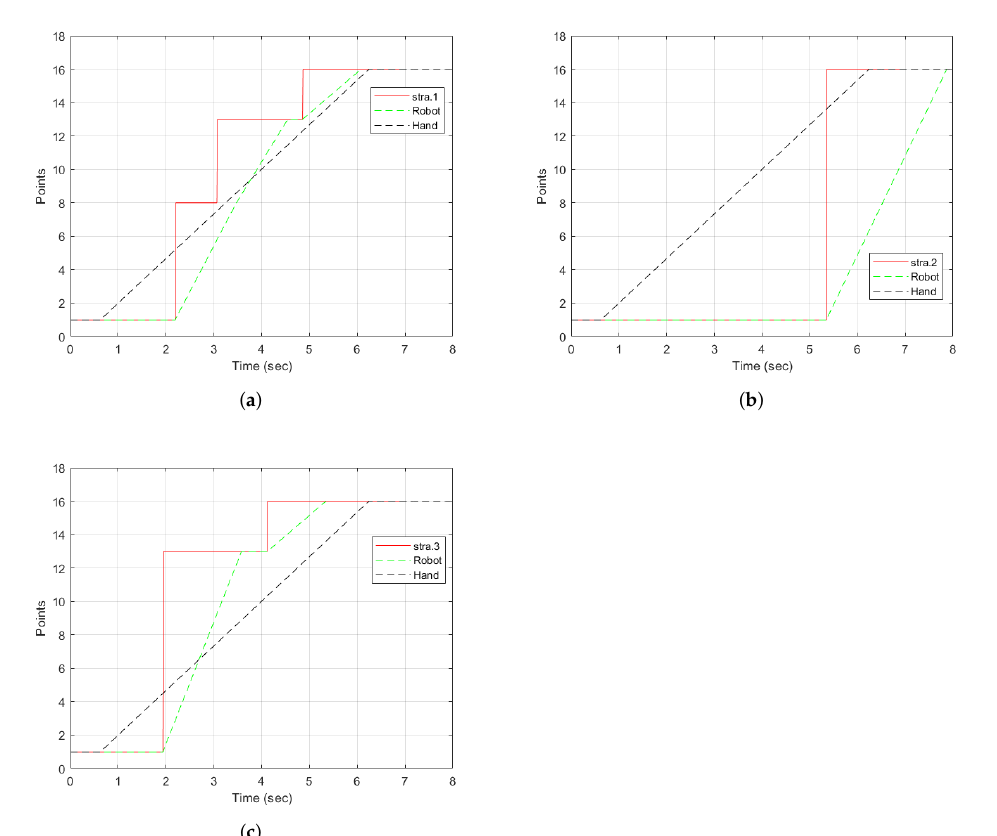
Figure 12. Results of individual strategies selection with the hand and robot motion for the trajectory from P 1 to P 16 showing the points selected by the strategies, the robot, and the hand stops. The dotted lines represent the motion of the hand and the robot. The graphs only show the points and the time the hand and robot stop. ( a ) Selected points using strategy 1 along with the robot and hand stops. ( b ) Strategy 2 points selection along with the robot and hand stops. ( c ) Strategy 3 selection along with the robot and hand